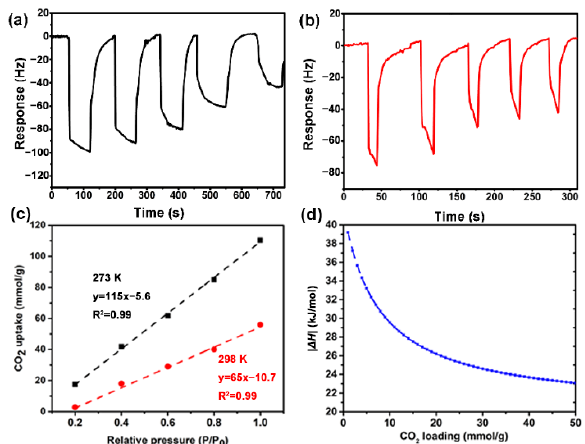
Figure 5. CO 2 absorption curves of the MOF-74 QCM sensor: ( a ) 273 and ( b ) 293 K. The CO 2 adsorption ( c ) isotherm and ( d ) enthalpy curve of the MOF-74.